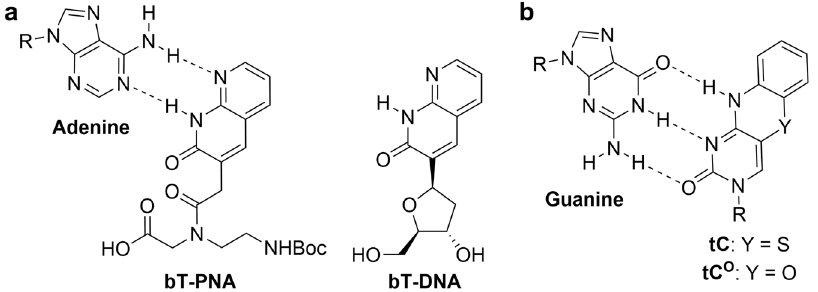
Figure 1. ( a ) The structure of the PNA- and DNA-derivative of bicyclic thymine (bT), base-paired with adenine. ( b ) The structure of tC/tC°, base-paired with guanine. R denotes the sugar-phosphate backbone.